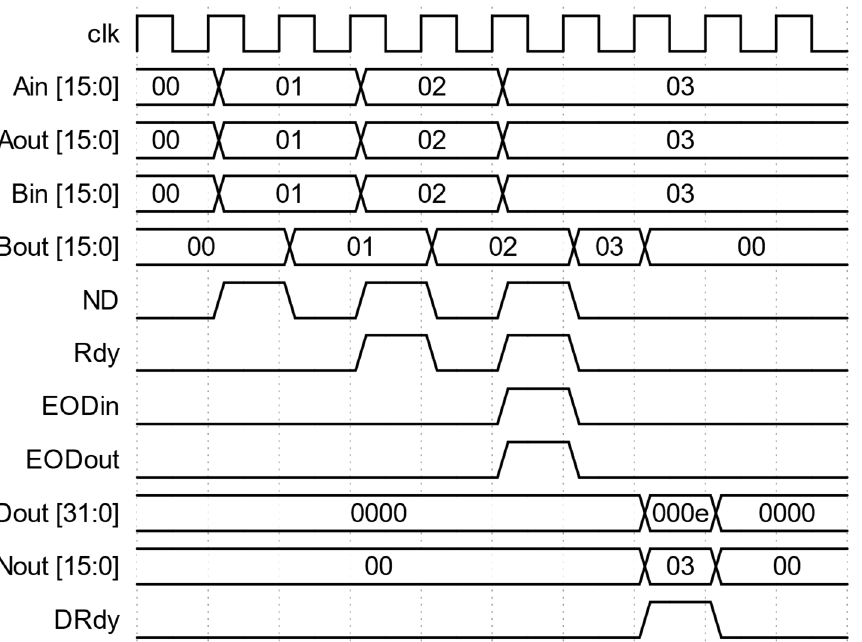
Figure 2. Waveforms of inputs and outputs for the SLC module. All values shown are in hexadecimal. The validity of the data is flagged by the corresponding active high valid signal.